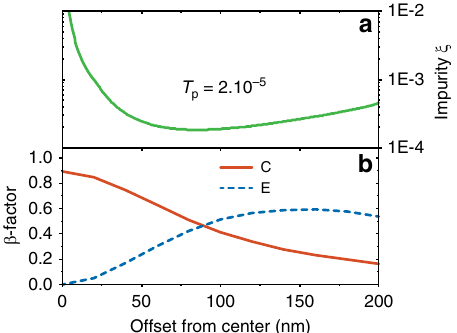
Fig. 2 Predicted device performance. a Expected single-photon impurity ξ for the experimentally achieved value of T p = 2 ⋅ 10 − 5 and as a function of different emitter locations in the waveguide. b Calculated β -factor for the two waveguide modes as a function of the offset distance of the emitter from the center of the